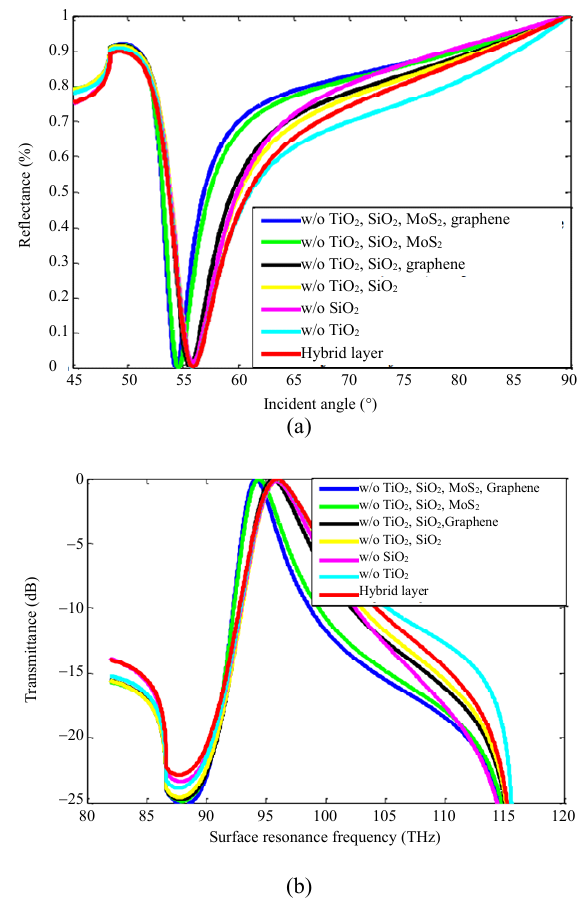
Fig. 4 SPR response curves of (a) reflectance (%) vs. incident angle (  ) curve and (b) transmittance (dB) vs. SPRF (THz) curve for different structures of